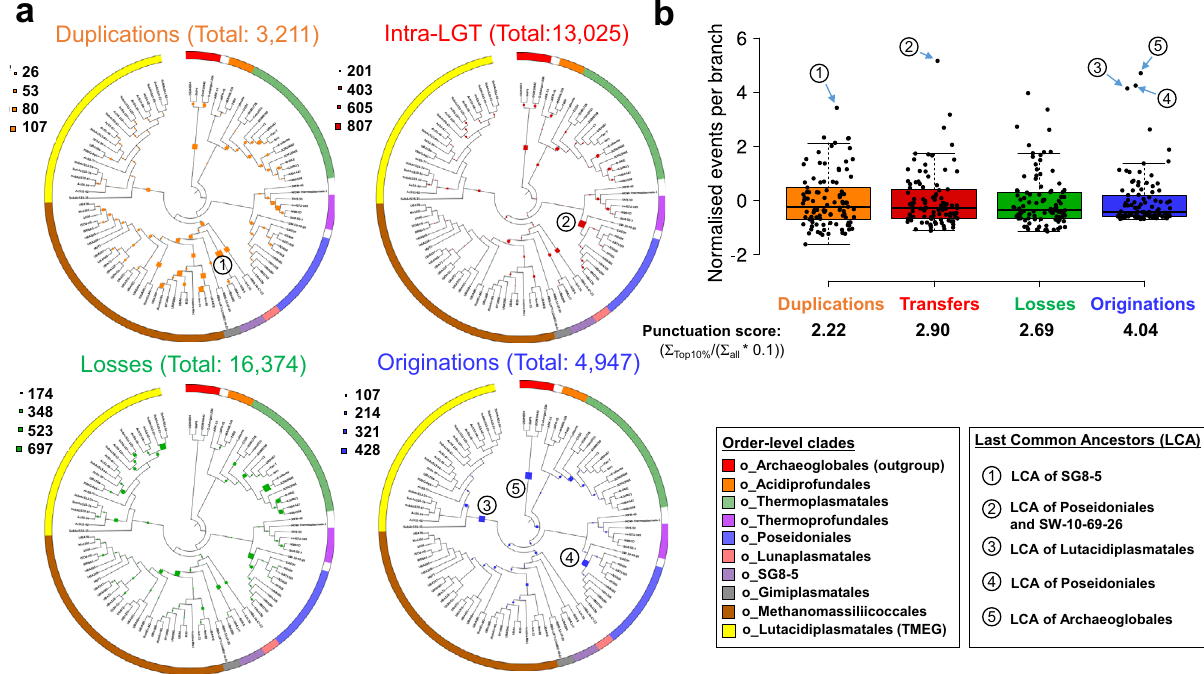
Fig. 3 Inferred gene originations, duplications, intra-phylum transfers and losses during the evolution of Thermoplasmatota. a The quantitative and qualitative predictions of the genome content changes were estimated across the Thermoplasmatota history and reported on the circular cladograms possessing the topology of the Thermoplasmatota tree (see Supplementary Fig. 6). The mechanisms of gene content changes quanti fi ed were duplication (copying of a gene within a genome), loss (loss of a gene within a genome), intra-phylum transfers (de fi ned as the acquisition of a gene from another member of the same phylum) (Intra-LGT) and origination (de fi ned as the acquisition of a gene from members of phyla outside the sampled genome set or by de novo gene formation). Scale numbers indicate the range of the predicted number of events for each given mechanism. The order-level classi fi cation of the genomes isindicated by the colouredbar surrounding the circle. b The boxplotsrepresent normalised eventsper branch ((eventsper branch - µ )/ σ ) for each mechanism. Numbered circles mark branches of the tree with the highest numbers of events, and the position of these branches is also indicated with numbered circles on the trees (in a ). Horizontal lines within boxes indicate the medians, box boundaries indicate the 1 st and 3 rd quartiles, whiskers indicate the minima and maxima, and points beyond these whiskers are outliers. A punctuation score is measured for each given mechanism. It represents the sum of events in the 10% of branches with the highest event numbers divided by 10% of the sum of events into all branches ( Σ events in top10% /( Σ events in all branches *